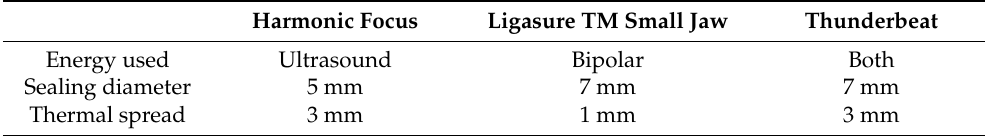
Table 1. Specifications of commonly used vessel sealing devices in thyroid surgery. Harmonic